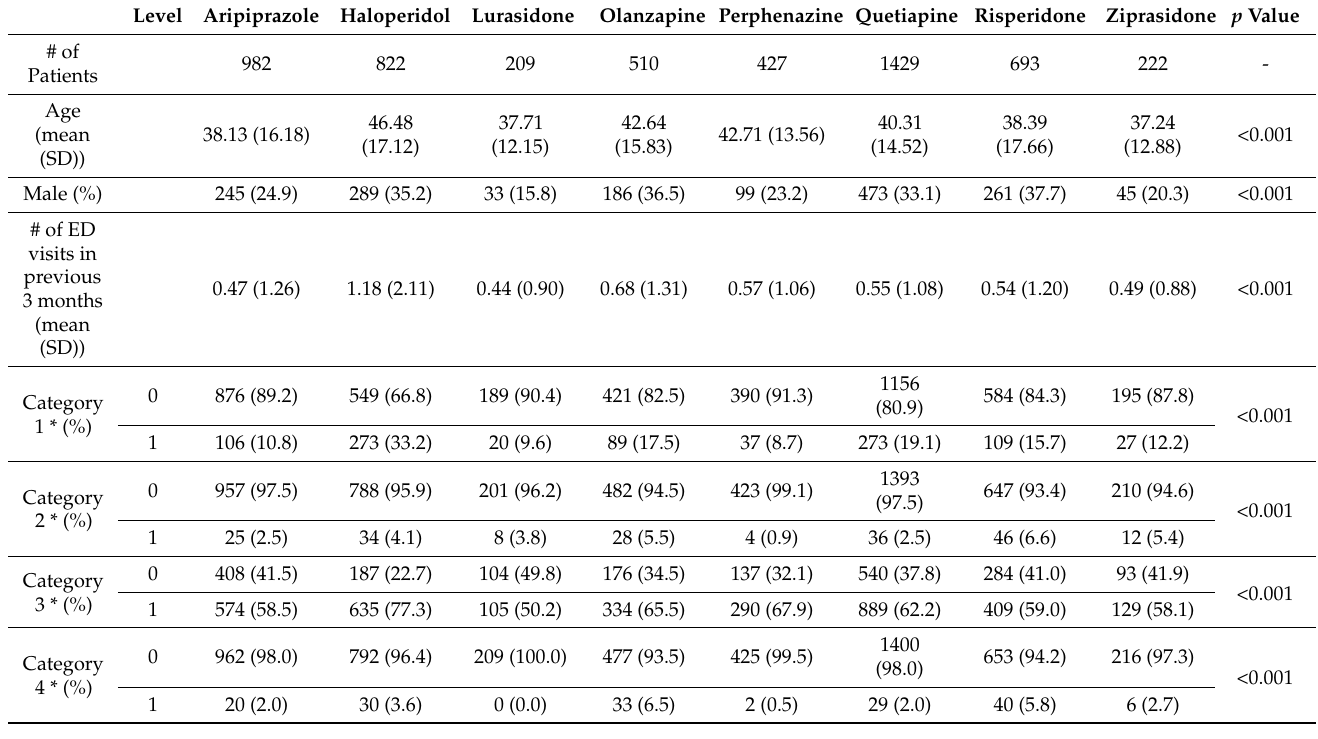
Figure 2. Enrollment process for emulation. Patients were right censored if they had no SREs at the end of the study period (i.e., administrative censoring), if a person failed to return for a study visit (i.e., lost to follow up), if they stopped using the antipsychotic of interest (no records of use within 3 months), or if they switched to another antipsychotic. SRE: suicide- related events.